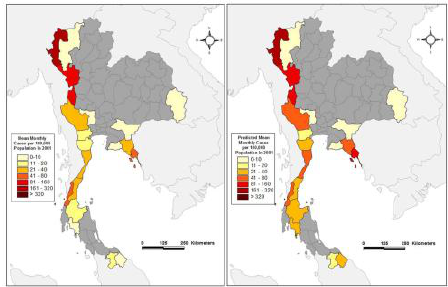
case rates in Thailand